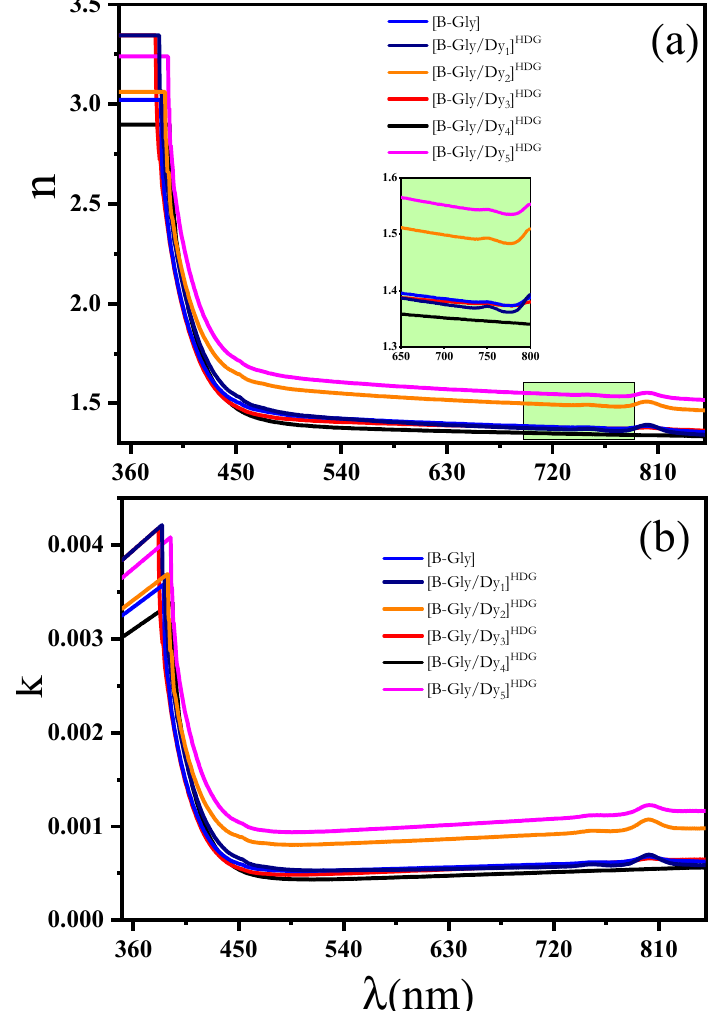
Figure 6. The relationship between the investigated glass samples ( a ) refractive index (n) and ( b ) extinction coefficient (K) for different concentrations of Dy 2 O 3 on the wavelength λ (nm).